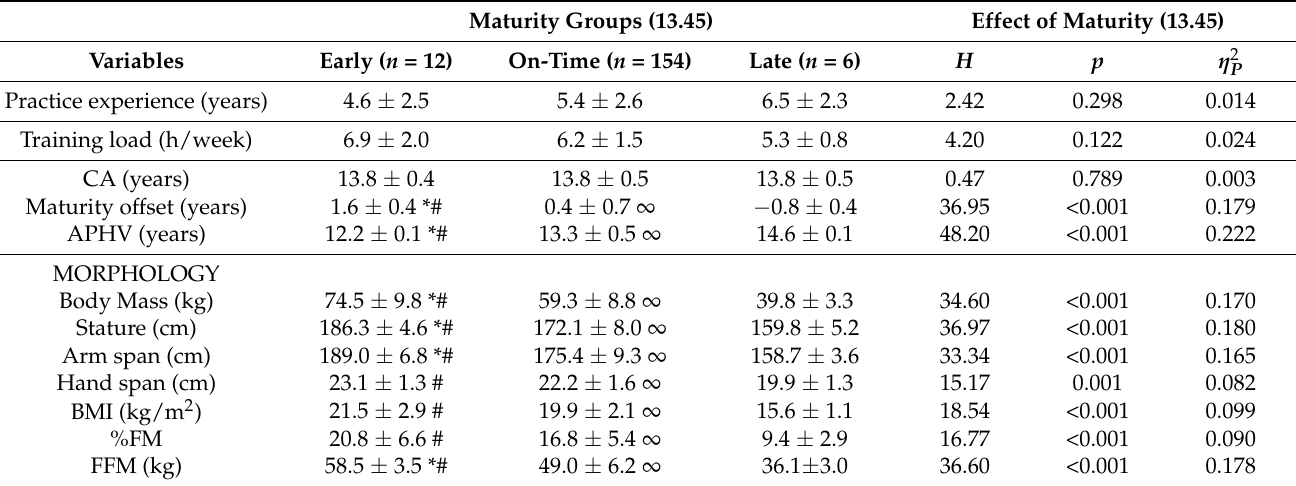
Table 4. Descriptive statistics (mean and standard deviation) and results of Kruskal-Wallis tests to evaluate the effect of maturity groups (APHV = 13.45) in U14 years basketball players’